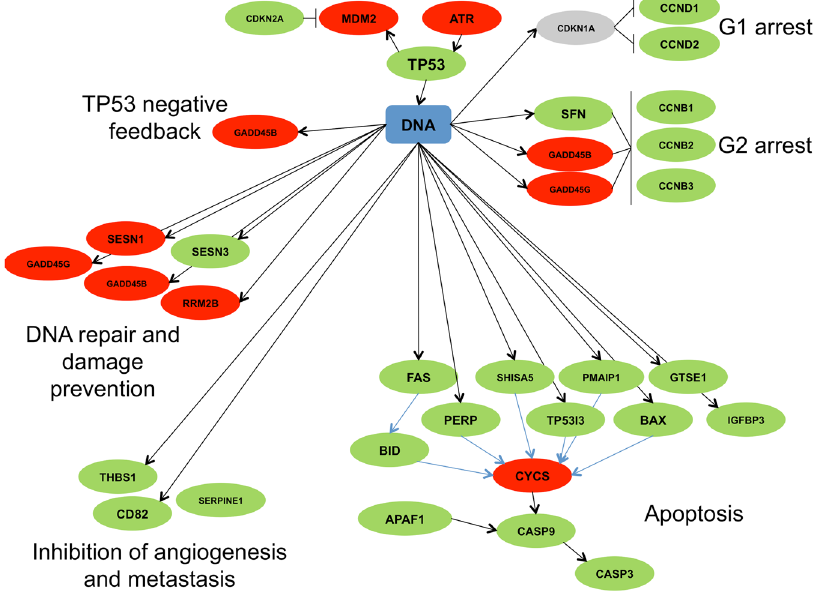
Figure 3. Map of DEGs in Oncopig leiomyosarcomas and their functions within the TP53 signaling pathway. Adopted from the KEGG hsa04115 p53 signaling pathway. Green ovals represent genes with elevated expression, red ovals represent genes with reduced expression, and grey ovals represent genes with no expression change in Oncopig leiomyosarcomas compared to controls. Black bars represent inhibition, black arrows represent activation, and blue arrows represent indirect effects.